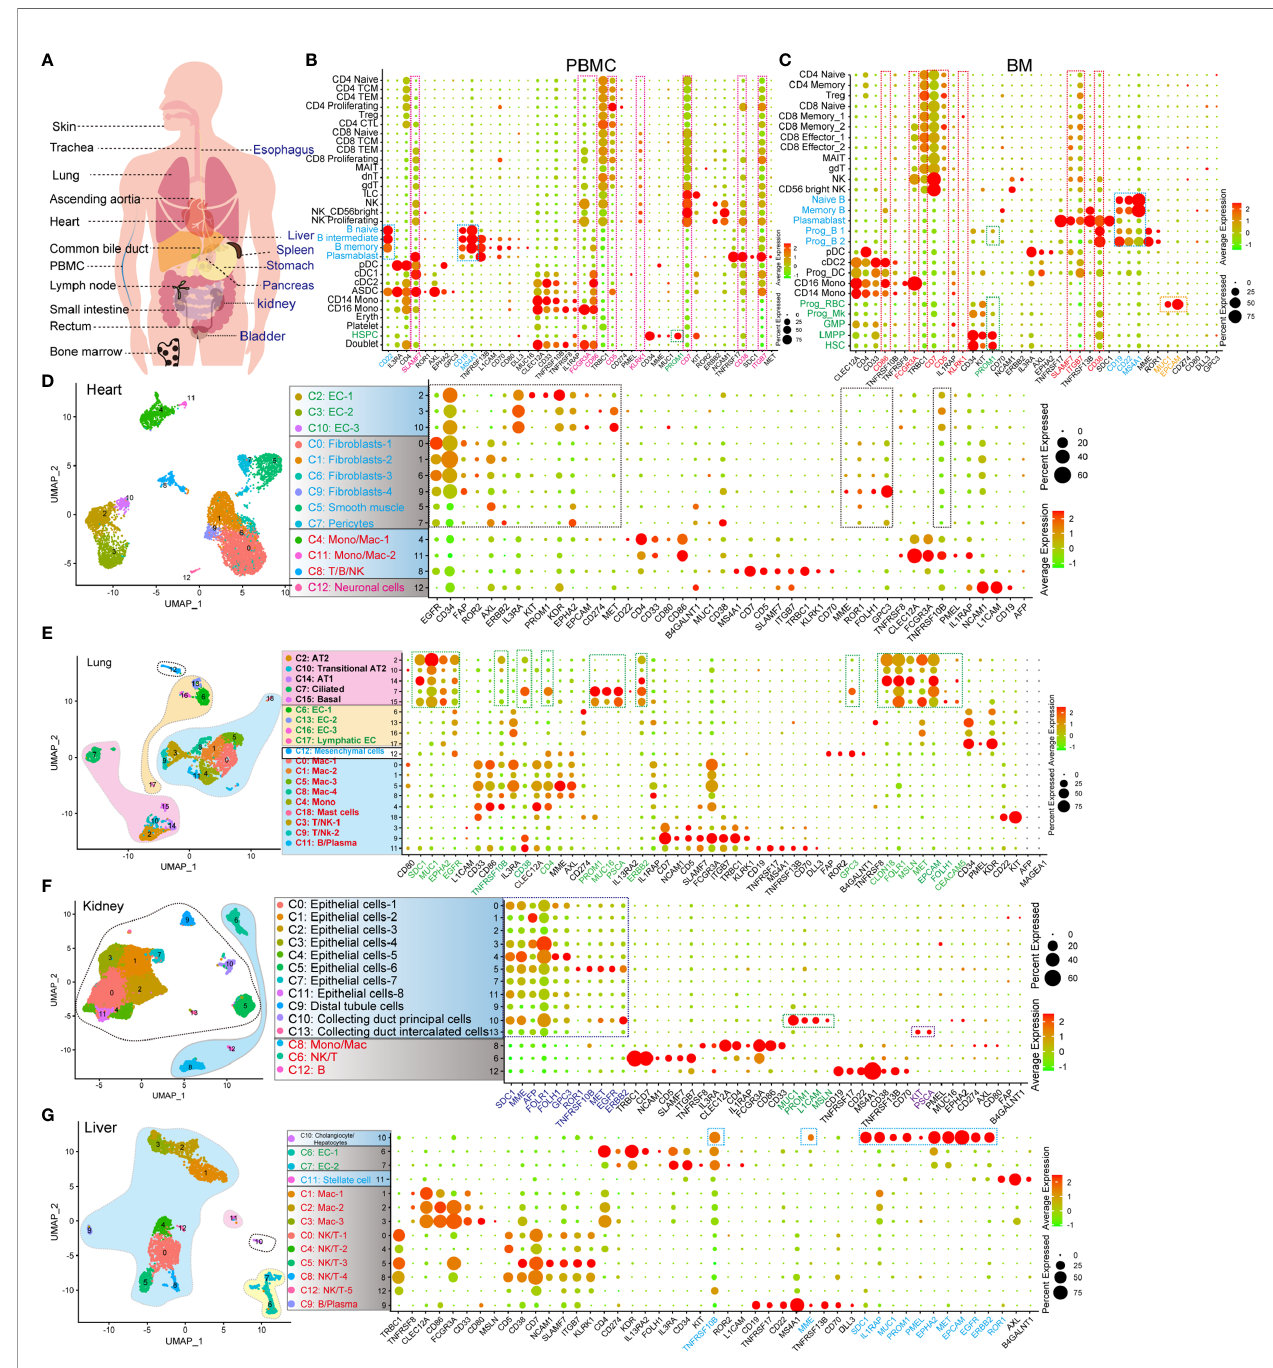
FIGURE 1 | Identi fi cation of the expression pattern of CAR target antigens in normal tissues and organs at single-cell transcriptome level. (A) Schematic representation of selected tissues and organs for analyzing target antigens. (B) Dot plot shows the expression levels of CAR target antigens in PBMCs. (C) Dot plot shows the expression levels of CAR target antigens in BM. UMAP projections of heart-derived cells (D) , lung-derived cells (E) , kidney-derived cells (F) , and liver- derived cells (G) , colored by clusters, and dot plots showing the expression level of CAR target antigens in different